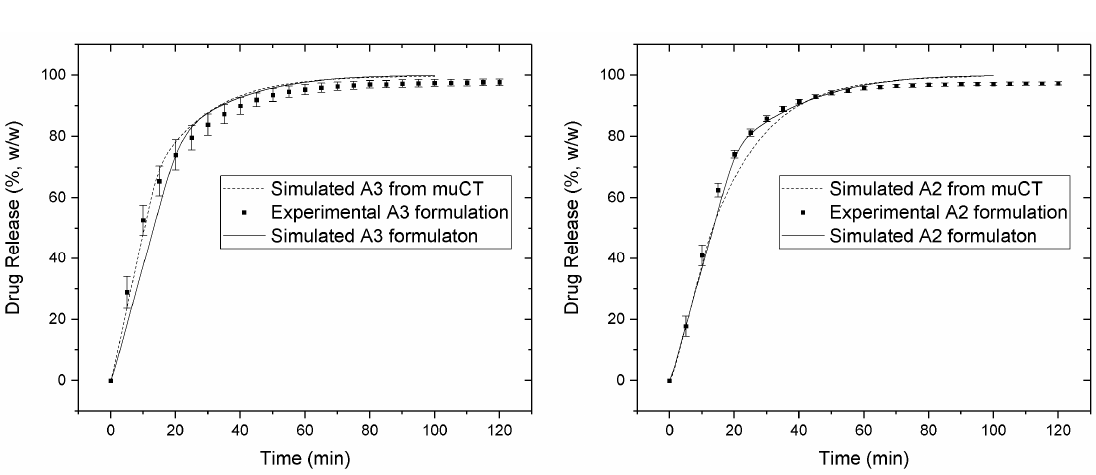
Figure 5. Comparison between in silico and in vitro release profiles obtained from simulations with algorithmically created tablet component arrangements and the reconstructed matrices with the help of microtomography for formulations A3 ( left ) and A2 ( right ).